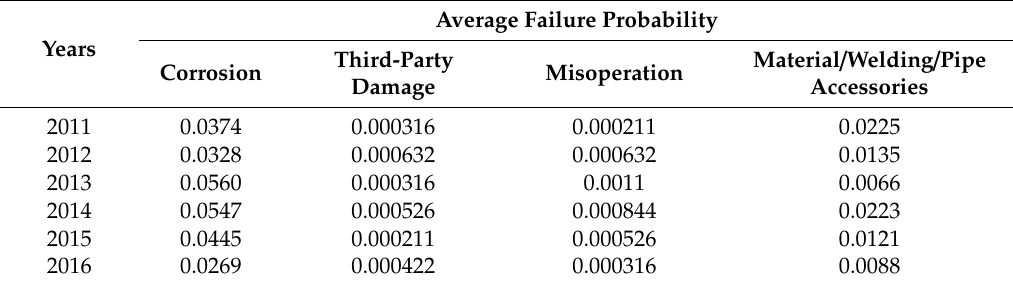
Table 7. Failure probability of intermediate